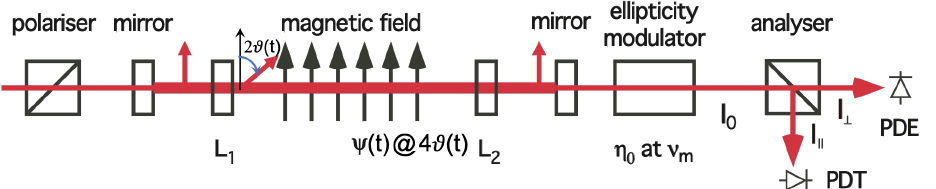
Figure 20. Schematic drawing of the polarization modulation scheme proposed for the VMB@CERN experiment. L 1 and L 2 are two HWPs co-rotating at ϑ ( t ) resulting in a polarization rotation at 2 ϑ ( t ) only inside the magnetic field. The induced ellipticity will be at 4 ϑ ( t ) . The rest of the scheme is identical to the PVLAS